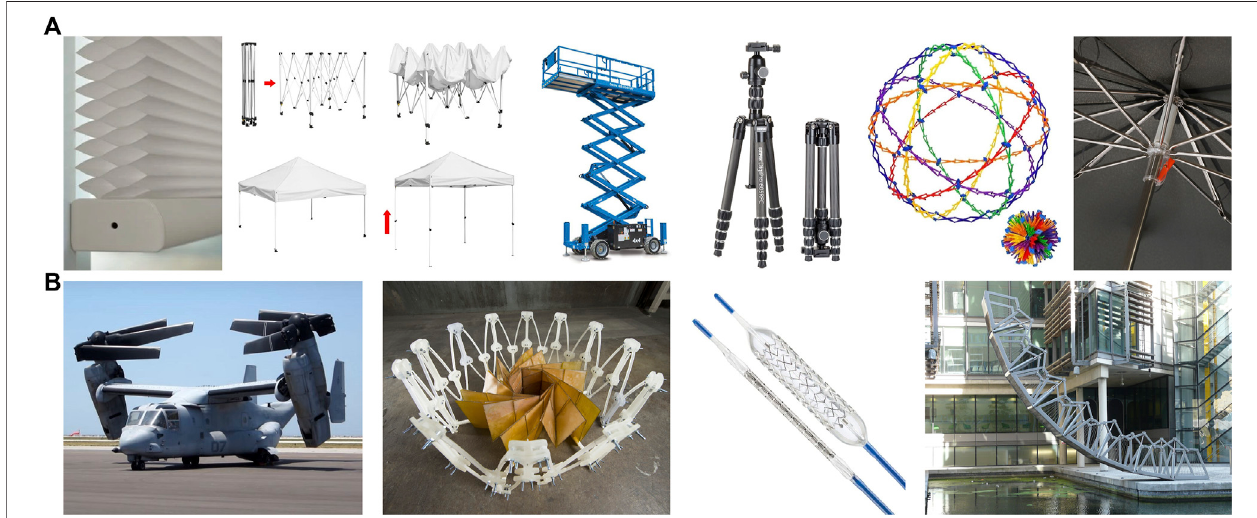
FIGURE 1 | Expandable structures are found in a variety of everyday items, such as window shades, canopies, construction equipment, tripods and stands, toys, and umbrellas (A) . Expandable structures are also used in a variety of industrial and scienti fi c purposes, including foldable aircraft, satellite design, medical devices, and architecture (B)